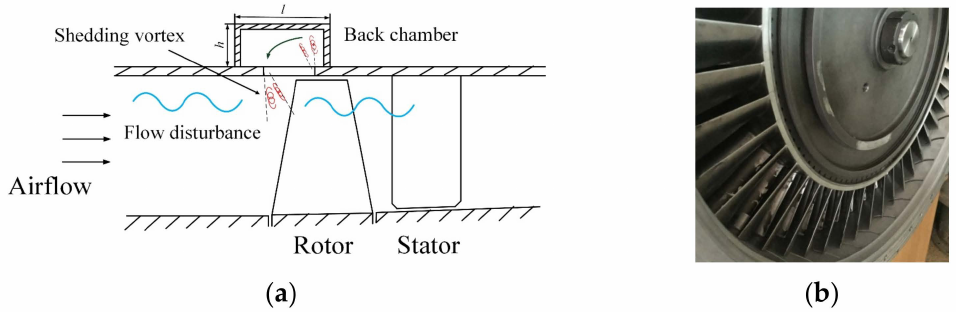
Figure 5. ( a ) Schematic diagram and ( b ) installation status of SPS casing